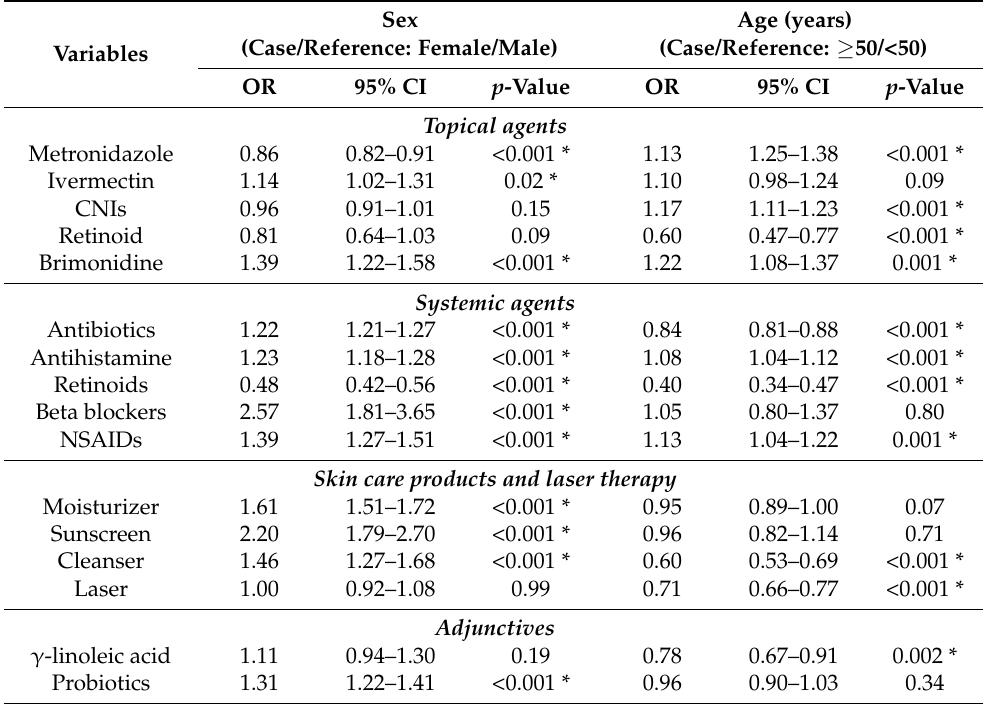
Table 2. Factors affecting prescriptions for rosacea by